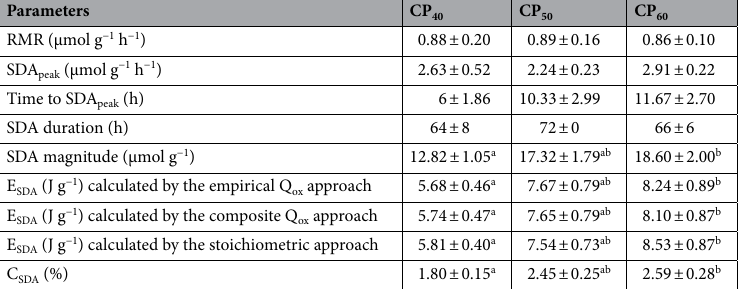
Table 1. Characteristics of the specific dynamic action (SDA) response in juvenile Sagmariasus verreauxi . Lobsters were reared at 21 °C and fed 15 N-labeled feeds at 1.5% body weight at three crude protein levels: 40%, 50% and 60%, corresponding to CP 40 , CP 50 and CP 60 treatments, respectively. RMR, routine metabolic rate; SDA peak , peak SDA; E SDA , SDA magnitude converted to energy; Q ox , oxycalorific coefficient; C SDA , SDA coefficient. All data represent mean ± standard error (SE) of 5 to 6 individuals. Different superscripts (a, b) in each row indicate significant differences among treatments (One-way ANOVA, P < 0.05).